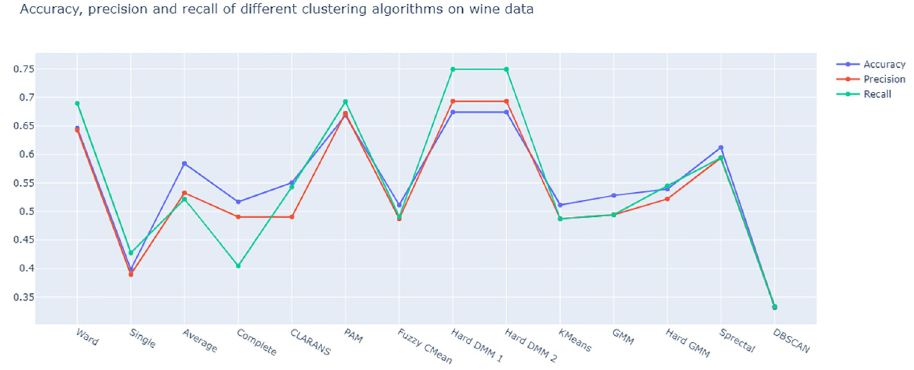
Fig 17. Plot of accuracy, precision and recall of different algorithms on on wine